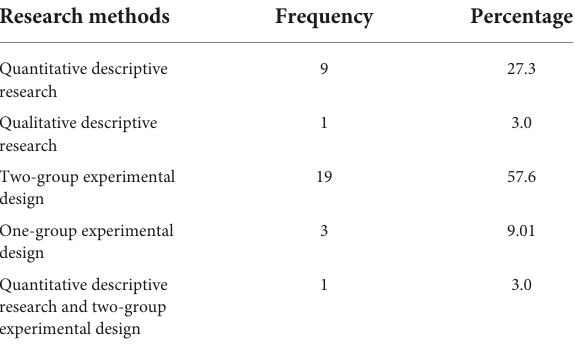
TABLE 3 Distribution of research papers related to uses of virtual and augmented reality in science and math education in Arab countries by research methods ( n = 33).